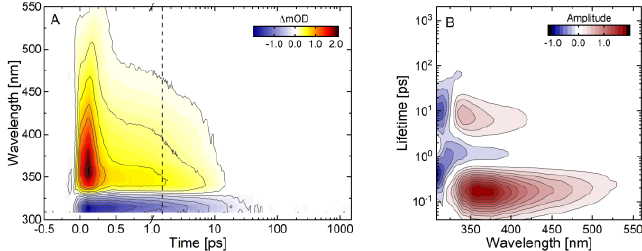
Fig. 2. Transient absorption data ( left ) and LDM ( right ) illustrating the ultrafast dynamics of ( E,E,E )- CTA after ππ * band